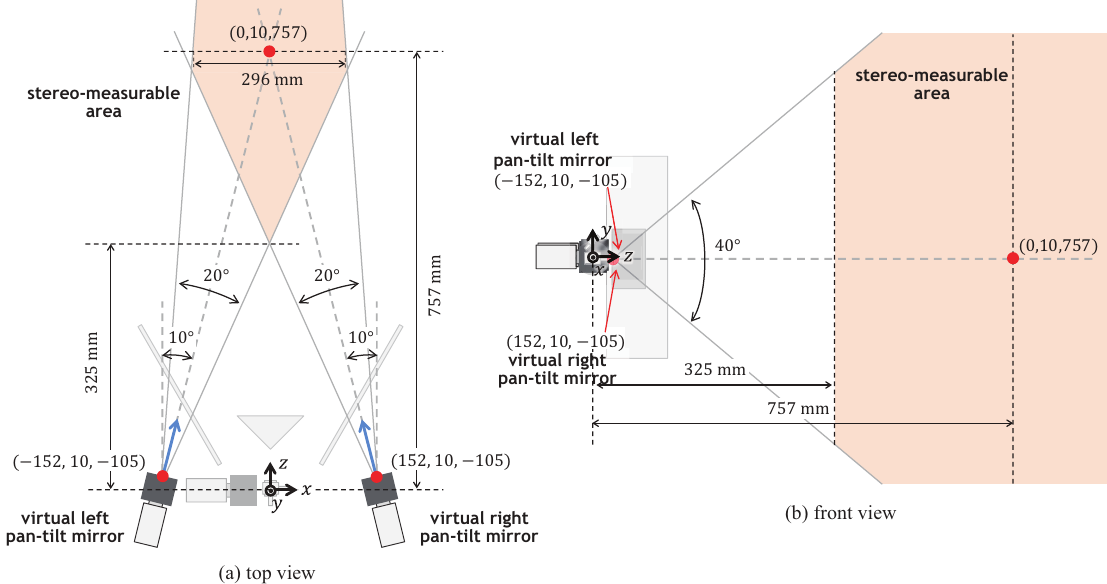
Figure 8. Virtual pan-tilt cameras and stereo-measurable area: ( a ) top view; ( b ) front